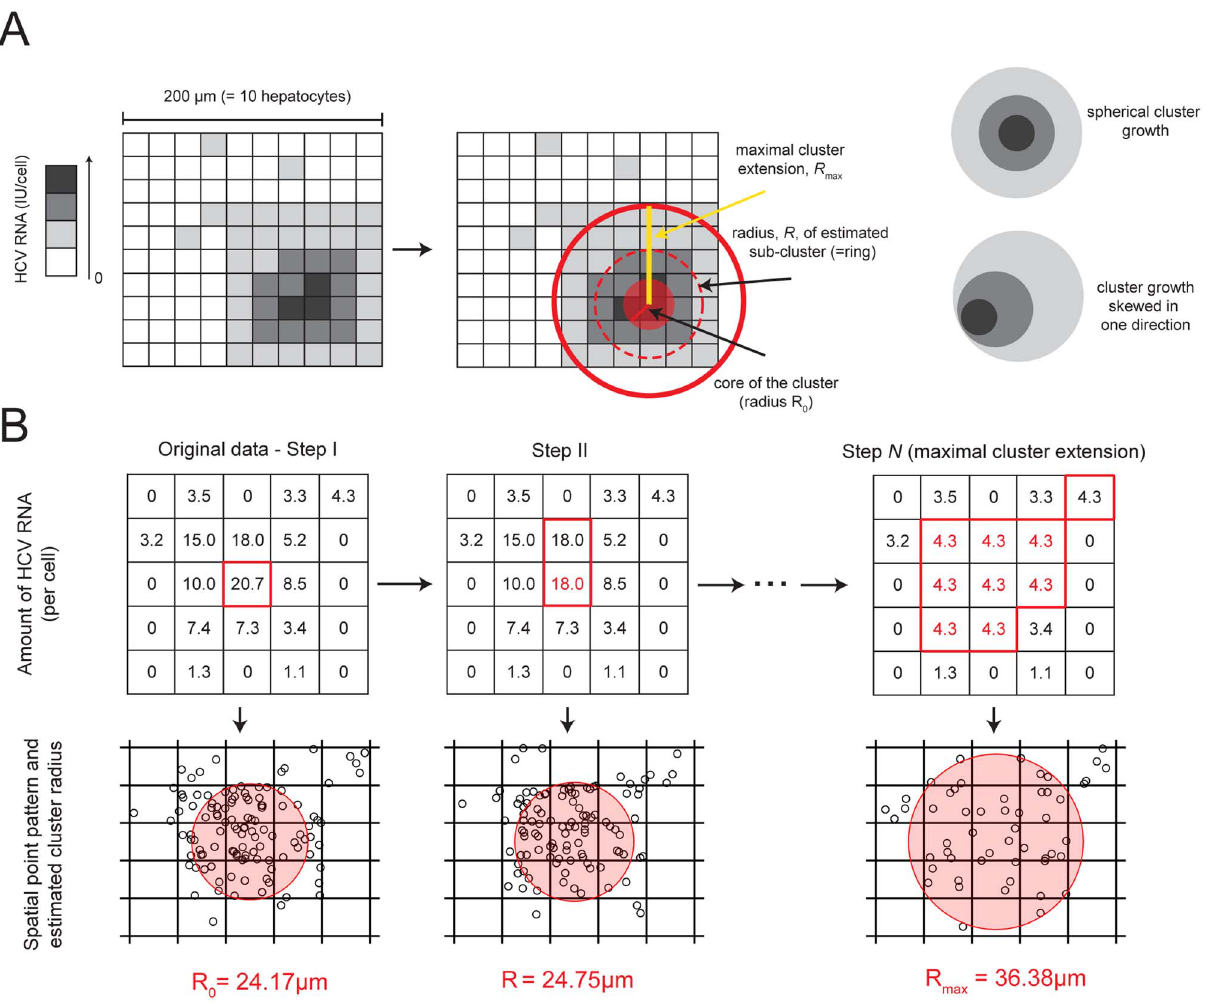
Figure 1. Sketch of the characterization of clusters of infected cells. ( A ) Example of measured data in a 10 | 10 grid of cells with the HCV RNA content per cell (left) and sketch of the ring structure of the cluster (right) as it would be defined by the algorithm shown in ( B ). Darker shading of cells indicates a higher amount of HCV RNA. The fitting procedure of the Mate´rn cluster process to estimate the domain radius R accounts for edge effects due to sampling, i.e., only parts of the cluster might be visible on the grid of liver tissue analyzed by scLCM. The sketch in ( A ) shows an example for a cluster that grew spherically. The algorithm also allows for cluster growth that is skewed in one direction. ( B ) Example of the algorithm to determine the ‘‘ring structure’’ of a cluster of infected cells for a 5 | 5 grid of cells. The measurements of HCV RNA per cell are transformed into a spatial point pattern (see Materials & Methods ). The amount of HCV RNA in those cells with the maximal HCV RNA content is subsequently reduced to the next lower level (red color) (Step I–Step II). For each of the different steps, 10 4 spatial point patterns are produced, and a Mate´rn cluster process is fitted to each pattern to estimate R . Step N shows the last step before the cutoff criterion for the maximal cluster extension. For all subsequent steps of this example Pearson’s chi-squared statistic for the point patterns indicated spatial heterogeneity for less than 95% of the 10 4 bootstrap